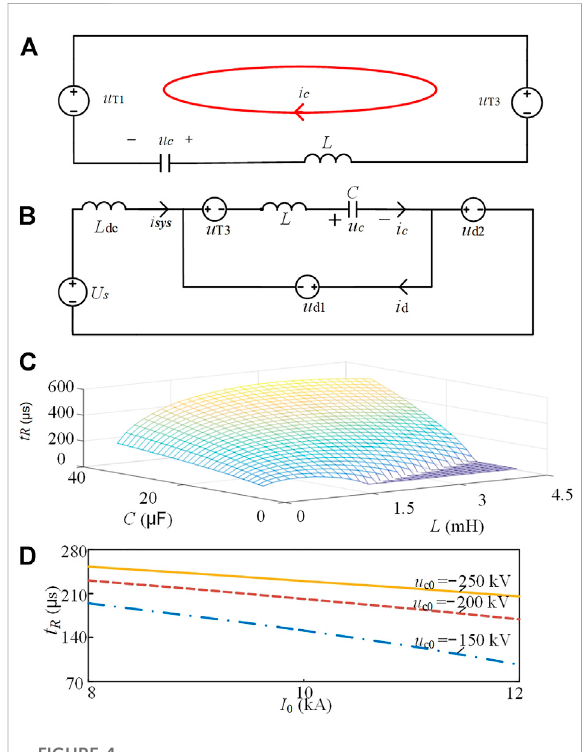
FIGURE 4 (A) Equivalent circuit of the capacitor discharging during t3 and t4. (B) equivalent discharge circuit of the capacitor during t4 and t5; (C) relations of tR, L, and C (D) relations of IR. Io. and